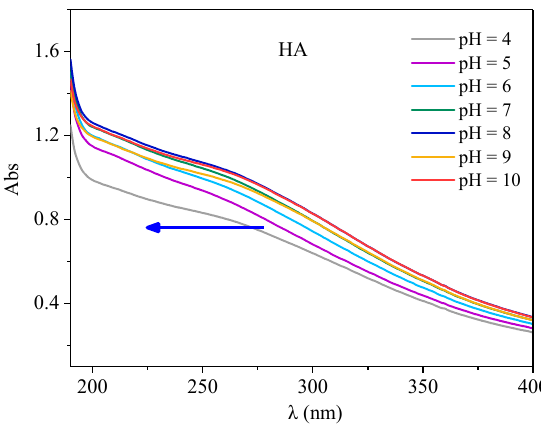
Figure 6. The UV- visible spectra of HA under different pH conditions. Figure 6. The UV-visible spectra of HA under different pH